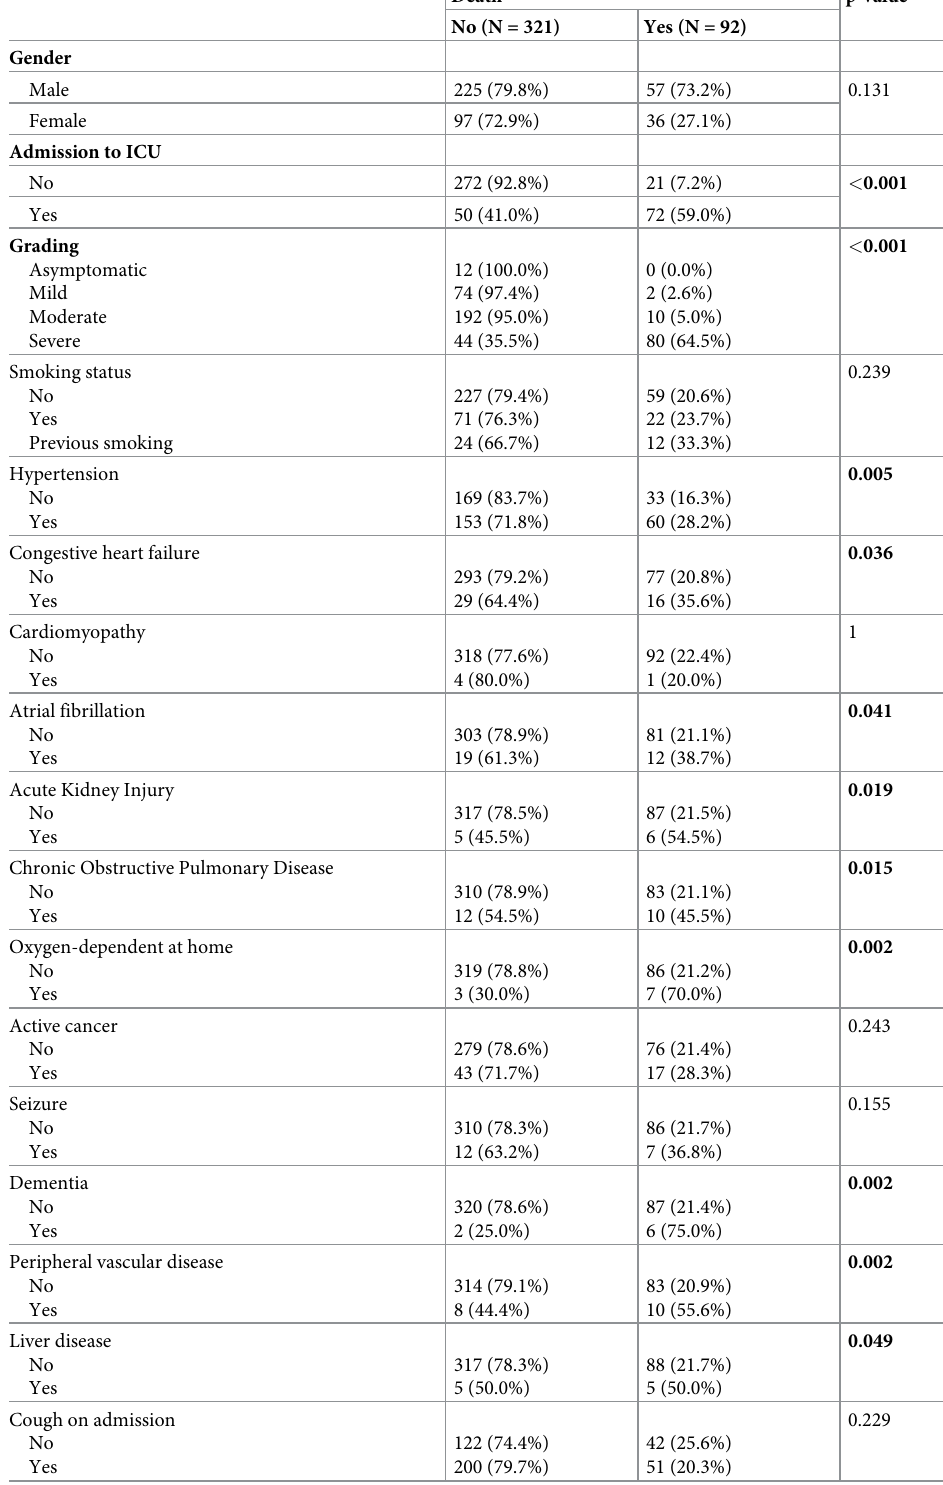
Table 2. Bivariate analysis of death as the dependent